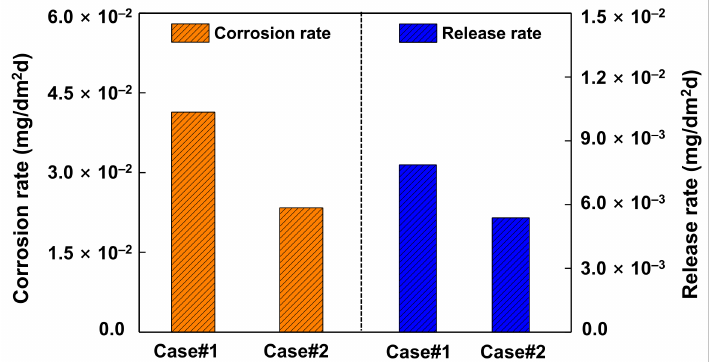
Figure 10. Corrosion and release rates of Alloy 690 after the corrosion tests in 2 ppm Li + 1000 ppm B solution without (Case #1) and with 60 ppb Zn (Case